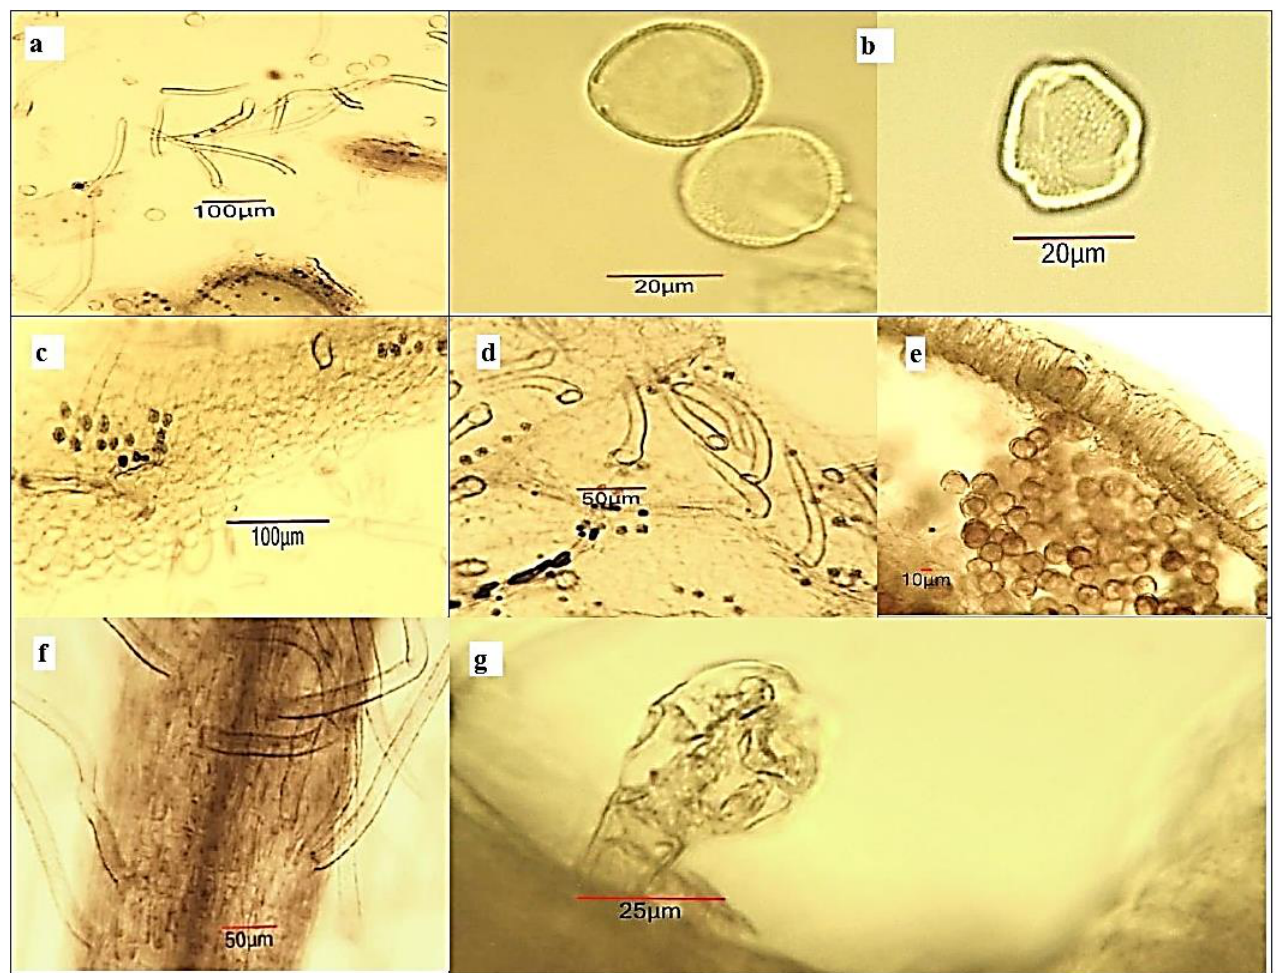
Figure 5. Microphotos of powdered flower substance of Ailanthus altissima : ( a ) scattered pollen grains and covering trichomes; ( b ) pollen grains with a pitted exine and 3 pores; ( c ) petal fragment with papillose epidermis and crystal druses, ( d ) sepal fragment with unicellular covering trichomes and crystal druses located mainly around the veins; ( e ) fragment of anther wall with exothecium and endothecium, and pollen grains; ( f ) fragment of funiculus with covering trichomes; ( g ) glandular hair trichome on flower stalk.